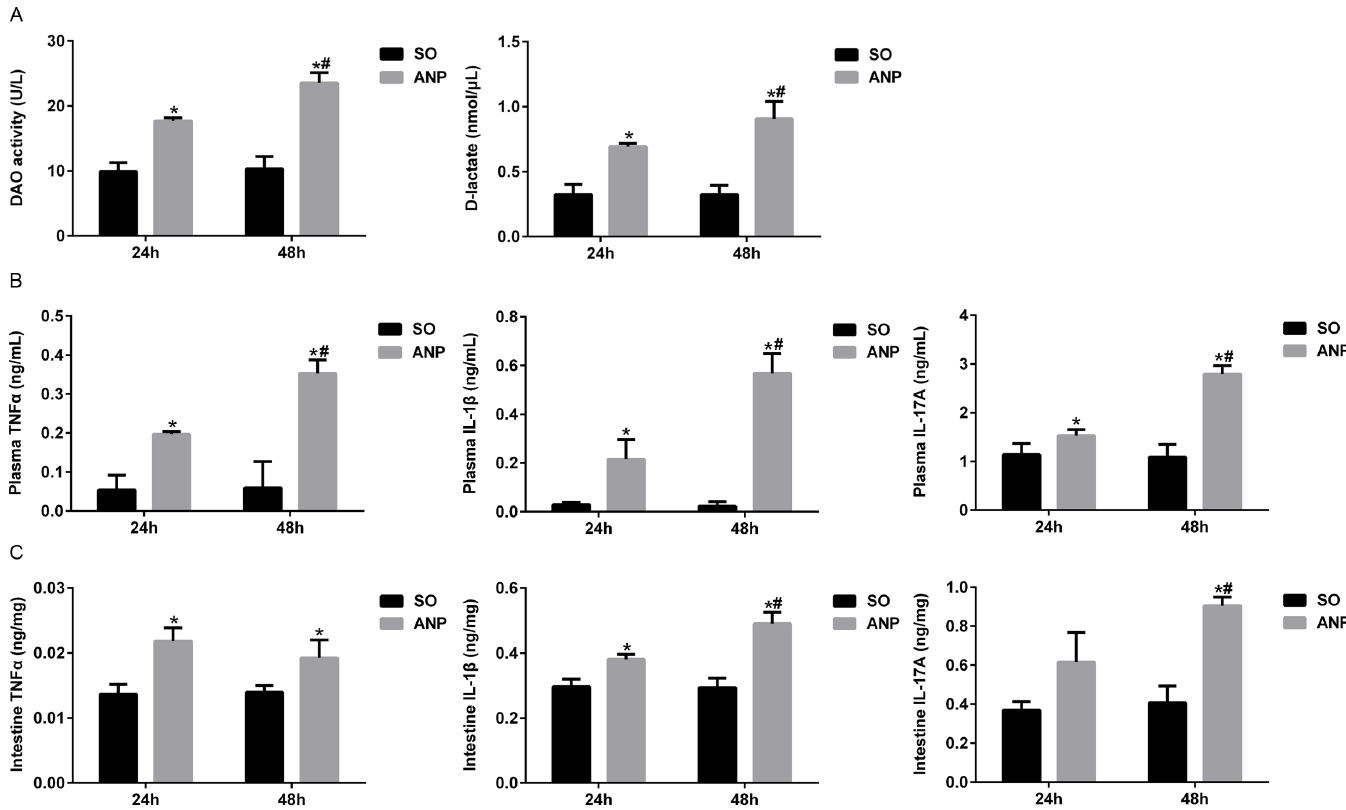
Fig 2. Changes in intestinal barrier permeability and the expressionof inflammatory cytokines in the plasma and the distal ileum during ANP. (A) Measurement of plasma diamineoxidase (DAO) activity and D-lactate at 24h and 48h after ANP induction.(B) Plasma inflammatory cytokines TNF α , IL-1 β and IL-17A levels in rats at 24h and 48h after ANP induction.(C) Intestinal inflammatory cytokines TNF α , IL-1 β and IL-17A at 24h and 48h after ANP induction. vs .SO * p < 0.05, vs .ANP24h # p <